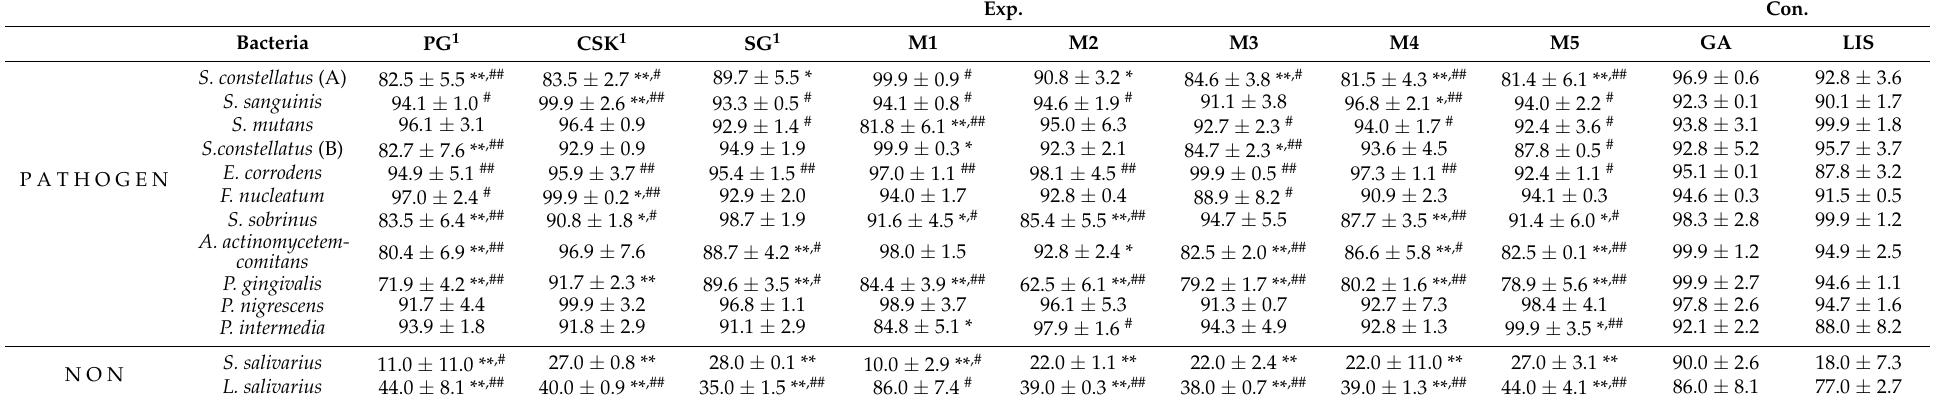
Table 4. The antibacterial effect on pathogenic and nonpathogenic oral bacteria. The antibacterial effect on microorganisms of each sample was measured, and the antibacterial ability of each result value was compared and observed with a chemical mixture mouthwash (GA, LIS). Each number represents a percentage. * vs. GA p < 0.05, ** vs. GA p < 0.001, # vs. LIS p < 0.05, ## vs. LIS p <